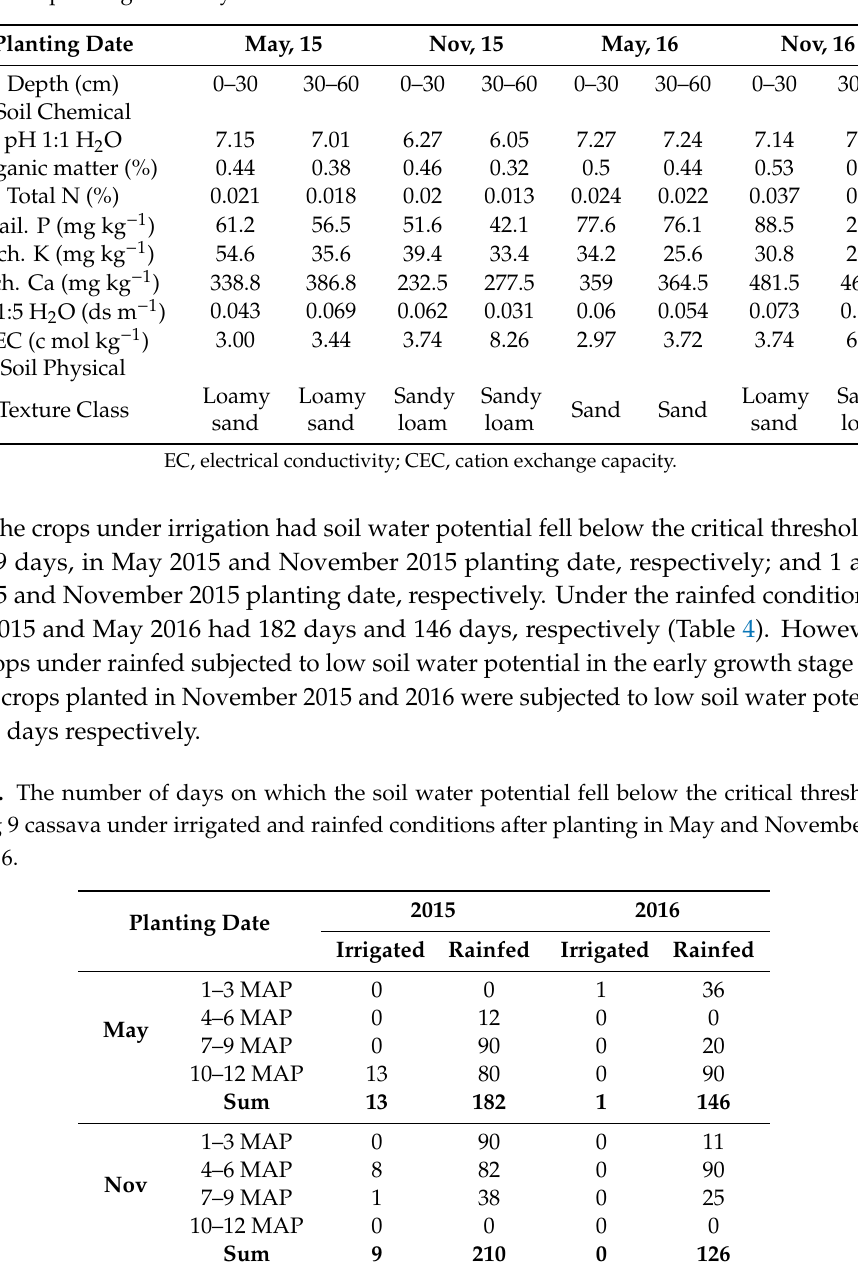
Table 3. Chemical and physical properties of the soil in the experimental fields at the depth 0 − 30 and 30 − 60 cm at planting date May and November 2015 and 2016. Planting Date